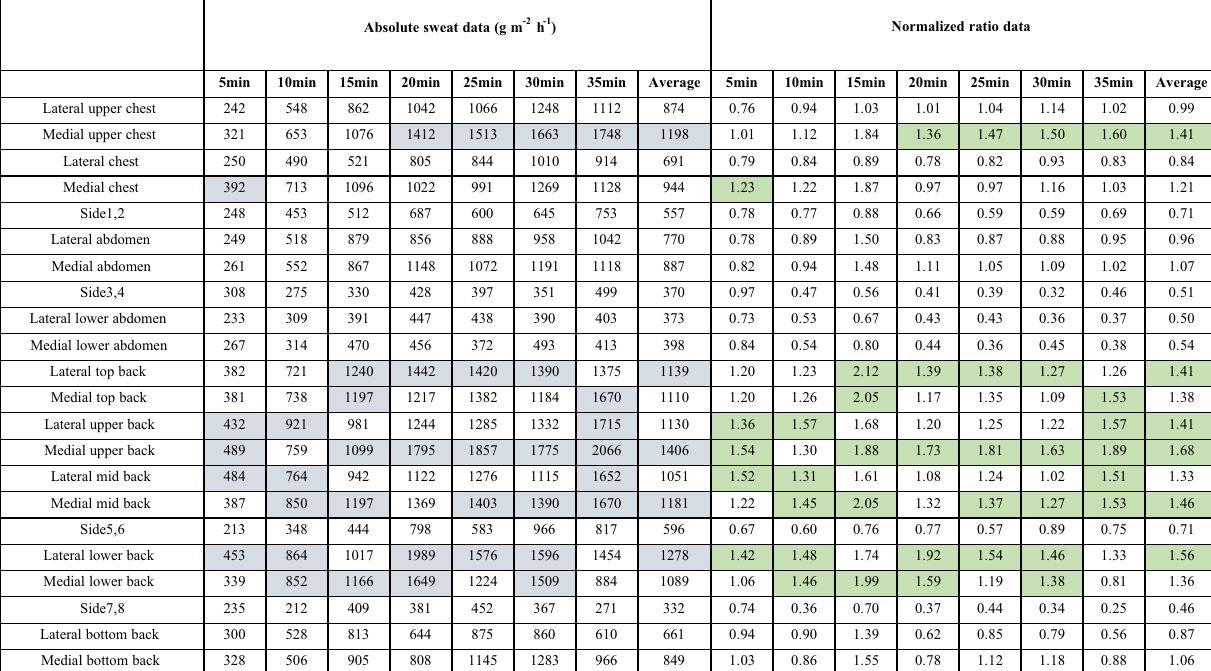
Table 3. Descriptive statistics for 35 regions sampled. The top five absolute values are showed by blue shading, and the top five relative values are showed by green shading.